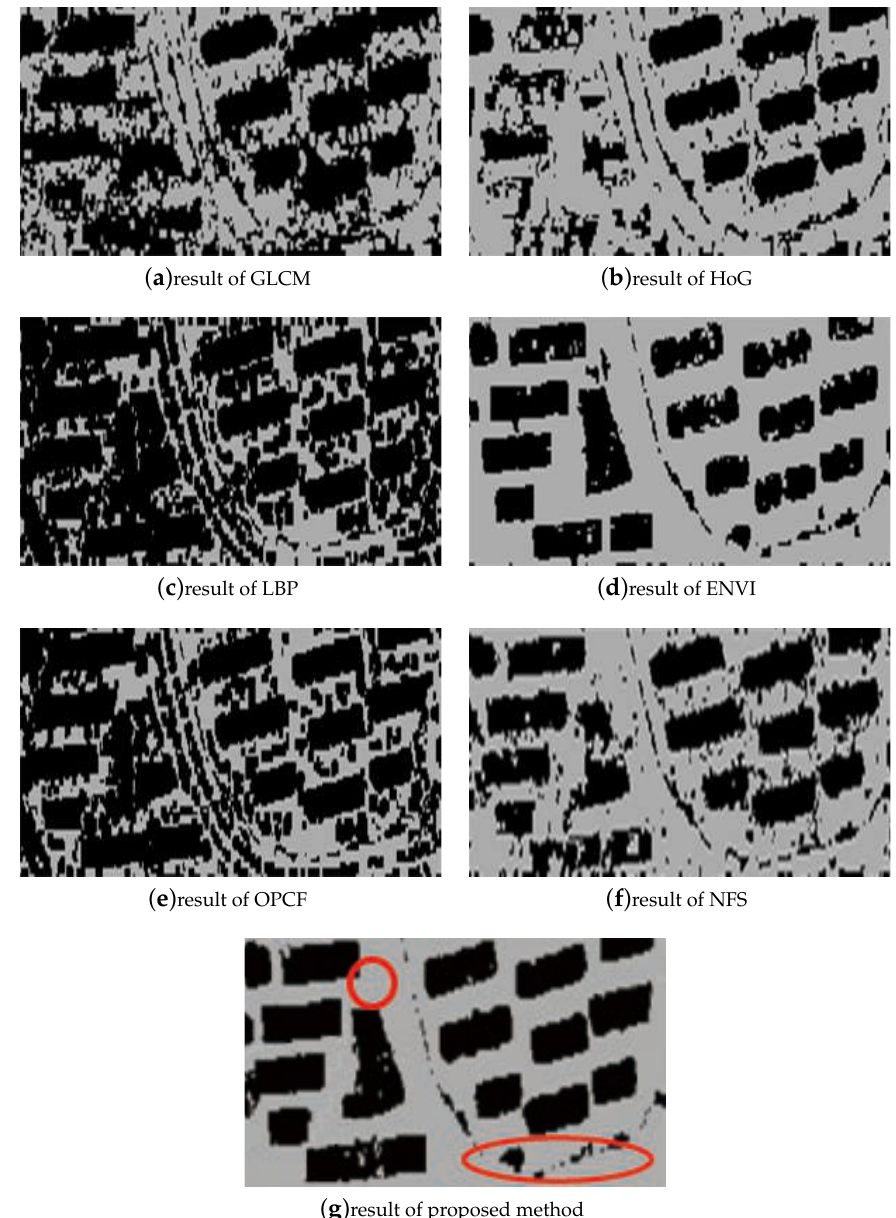
Figure 13. Building extraction results of HDR